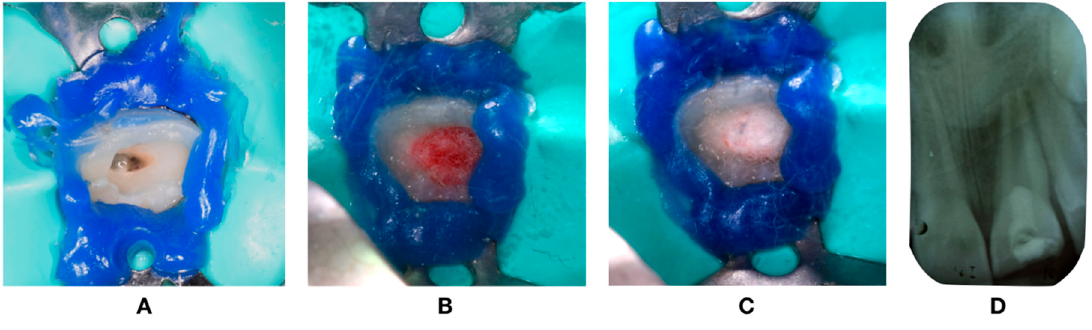
Figure 3. Intra-oral photography. ( A ) Coronary opening. ( B ) Blood clot. ( C ) MTA placed apical to cementoenamel junction. ( D ) Periapical radiograph after REP procedure.